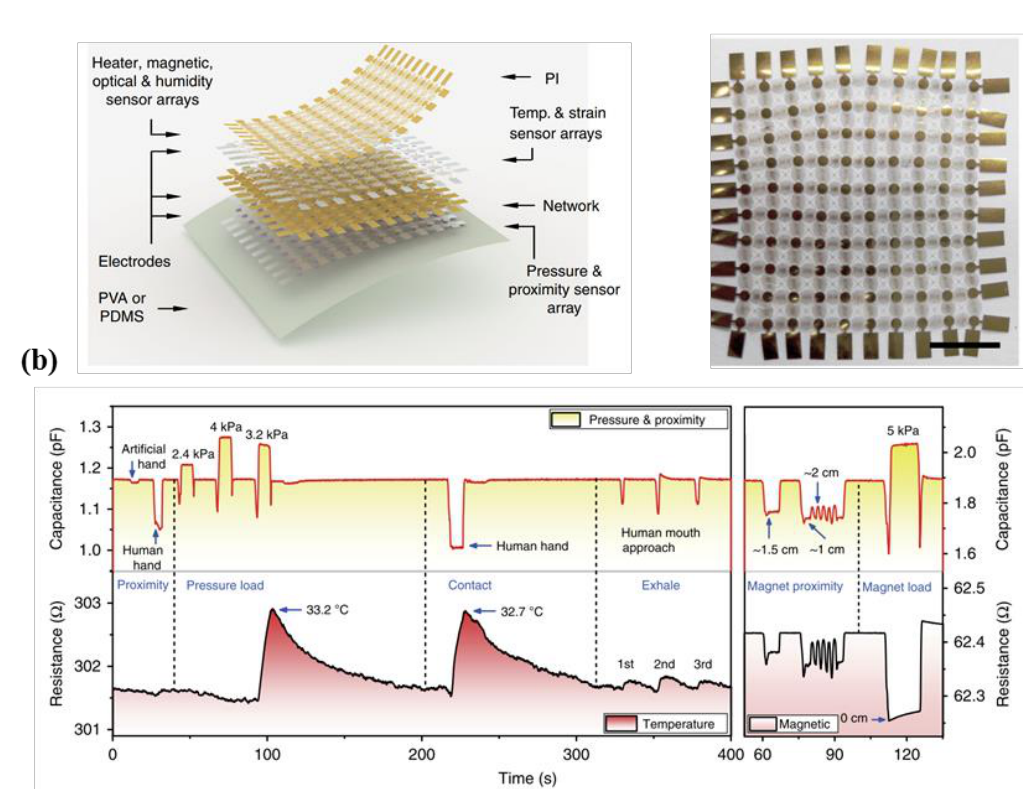
Figure 13. ( a ) Schematic illustration showing the stretchable and conformable matrix networks (left). Photographic image of the device (right); ( b ) sensing capabilities under various multiple stimuli (pressure, temperature, magnetic, and proximity) (reprinted with permission for Figure 13a,b from Ref. [140] under CC-BY 4.0 license).